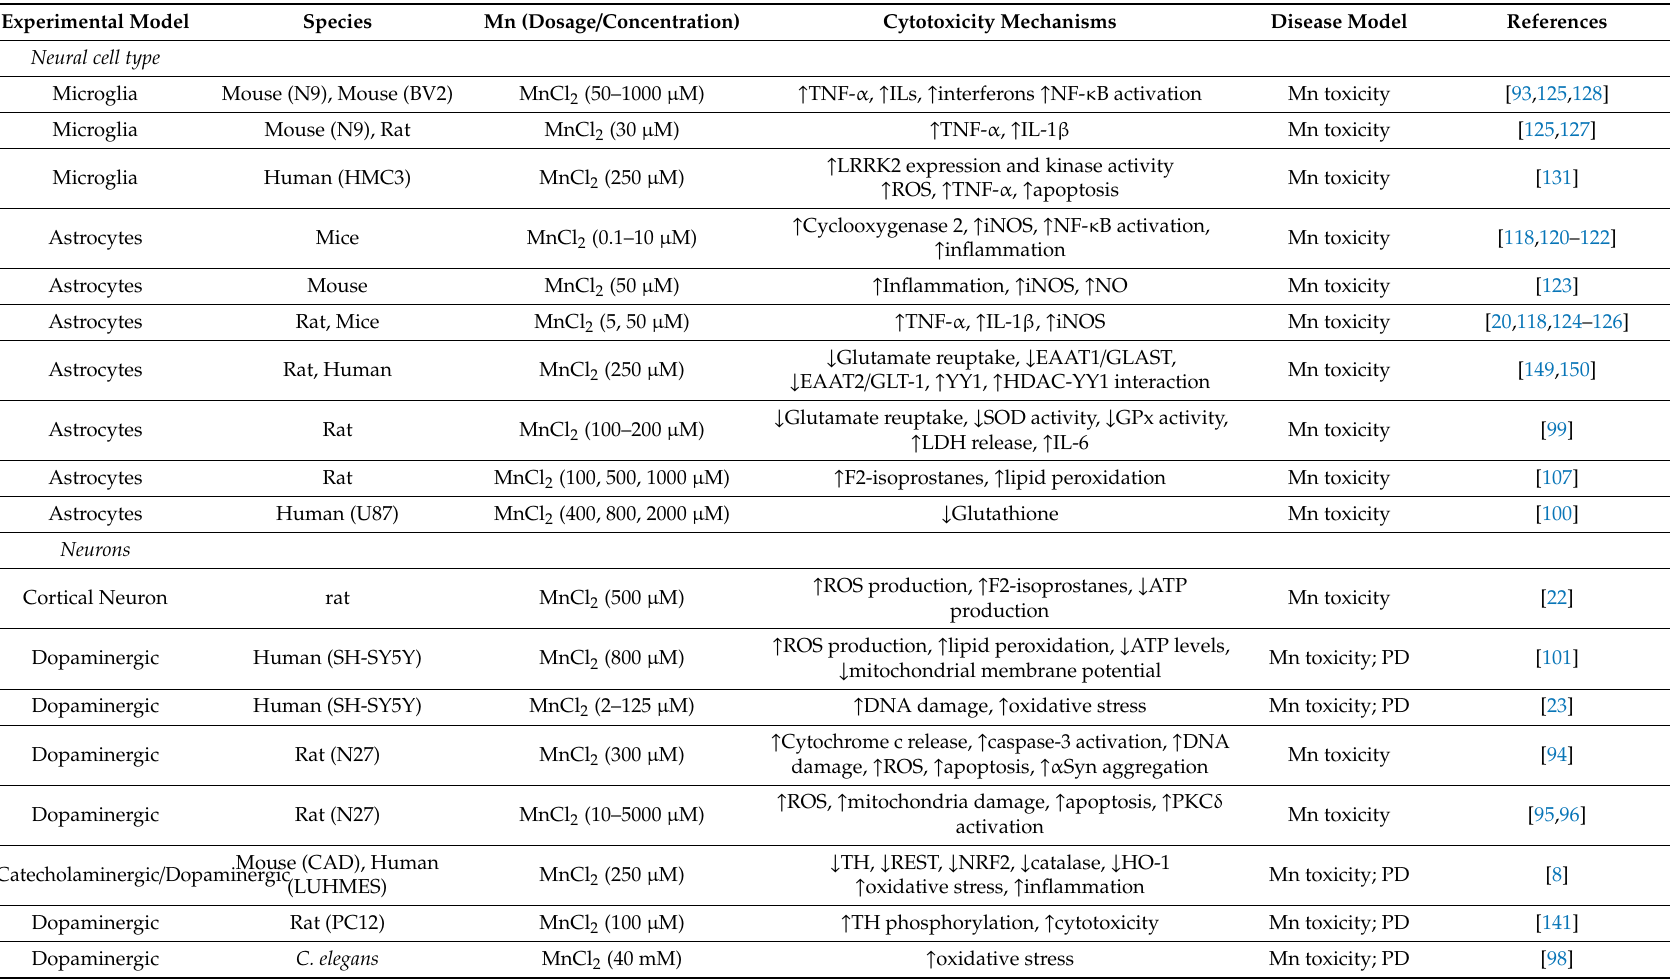
Table 1. The molecular mechanisms involved in manganese (Mn)-induced toxicity in various neural cell types such as microglia, astrocytes, and neurons and in multiple regions of the